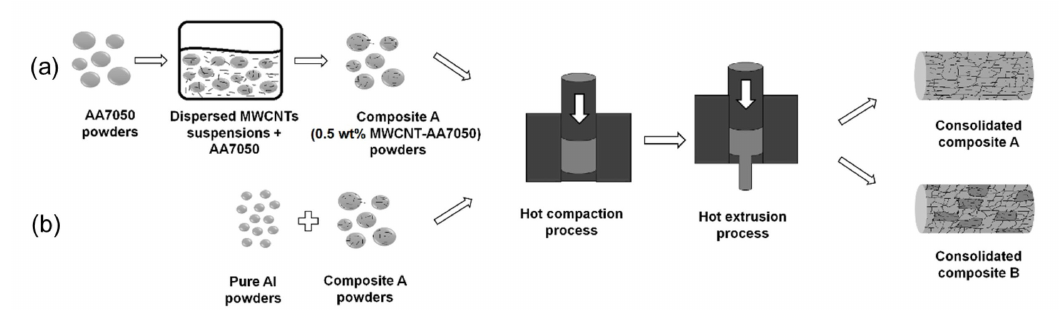
Figure 1. Representation of the powder metallurgy process of (a) composites A and (b) composite